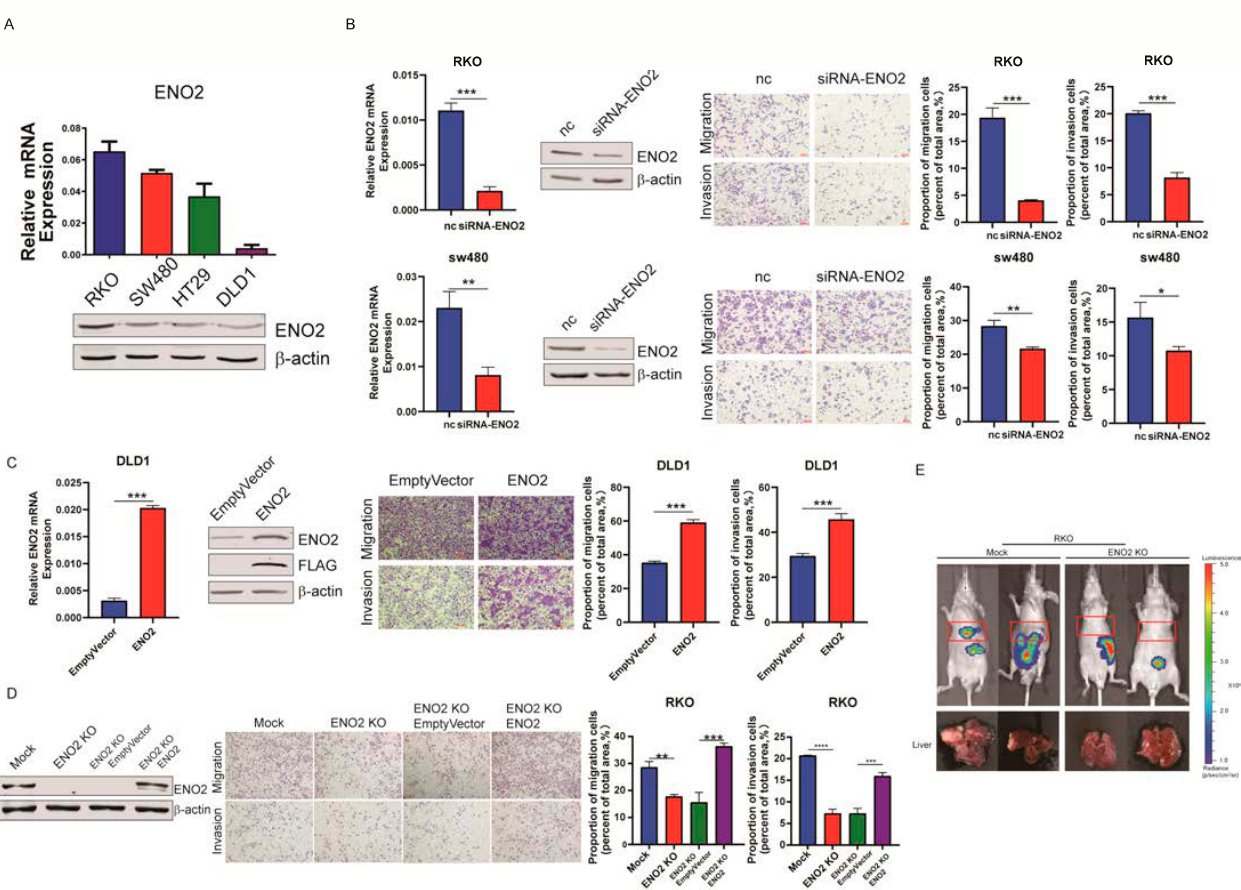
Figure 2. ENO2 promoted CRC migration and invasion in vitro and metastasis in vivo. ( A ): Expres- sion of ENO2 RNA (up) and protein (down) in CRC cell lines normalized to β -actin. ( B ): Identification of ENO2 knockdown and its effects on RKO and SW480 migration and invasion. Shown from left to right are mRNA as measured by qPCR, protein levels as measured by Western blot, representative transwell images and statistical results from the transwell migration and invasion assays. ( C ): The migration and invasion of DLD1 cells overexpressing ENO2. ( D ): Representative transwell results of the phenotypic rescue of ENO2KO cells. ENO2 was reintroduced into ENO2-silenced RKO cells. Characterization of ENO2 re-expression and the corresponding statistical analysis of migration and invasion. ( E ): Metastatic foci in a mouse model of liver metastasis. The red rectangles indicate the mouse liver region, n = 2. Values are presented as the means ± SDs, * p < 0.05, ** p < 0.01, *** p < 0.001, **** p < 0.0001.